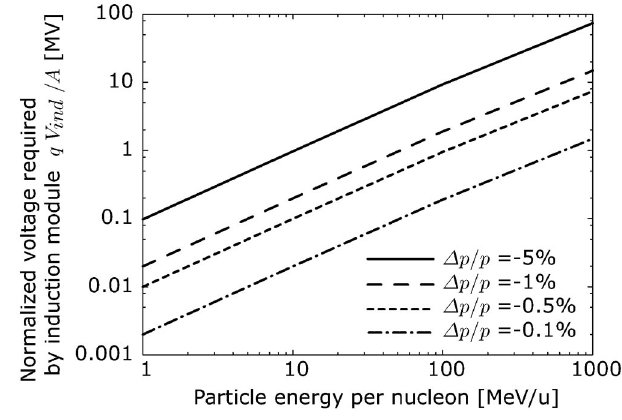
FIG. 2. Particle energy modulated by an induction-voltage (cid:3) (cid:1) V < V , (a) at the analyzer and modulator for V (cid:2) V f ind limit (b) after the induction-voltage modulator.